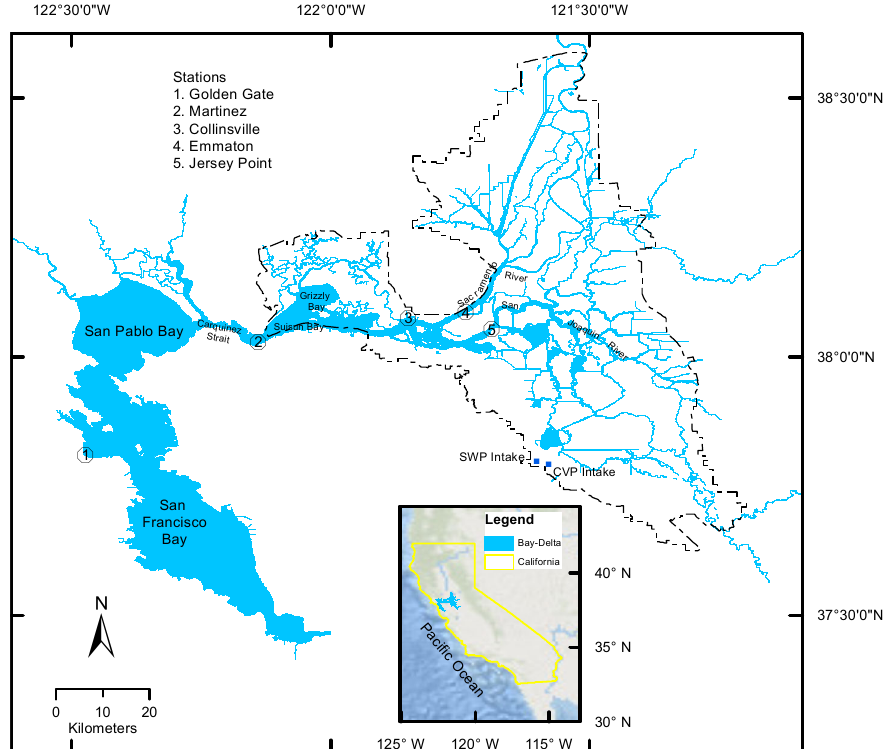
Figure 1. Location map showing the San Francisco Bay and Sacramento–San Joaquin Delta (Bay-Delta) Estuary and the study location Martinez along with several other key water quality stations including the Golden Gate, Collinsville, Emmaton, and Jersey Point. The dash line highlights the modeling domain of the Delta Simulation Model II (DSM2). The insert map illustrates the location of the Bay-Delta in